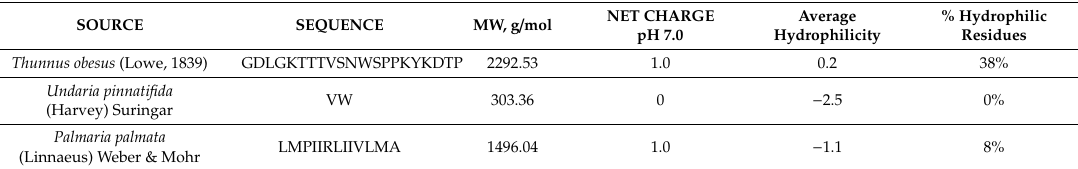
Table 2. Properties of the peptides investigated in molecular docking. It is worth mentioning that small cationic-amphipathic peptides are likely to show antiviral properties, so peptides in Table 2 from Thunnus obesus and Palmaria palmata are also good candidates for counteracting COVID19 as antiviral peptides. Notice that the peptide from Undaria pinnatifida is also found in other organisms (see Table 1). SOURCE SEQUENCE MW, g / mol NET CHARGE pH 7.0 Thunnus obesus (Lowe, 1839)